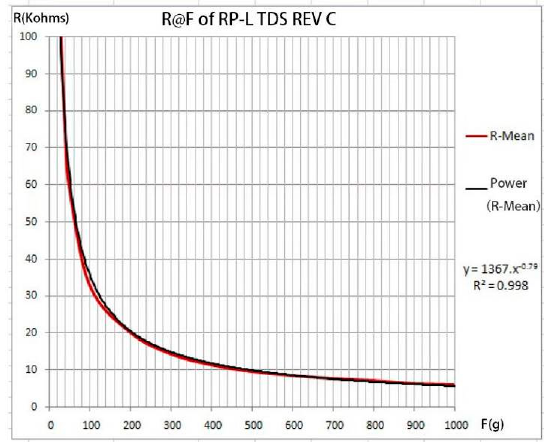
Figure 5. Pressure sensor calibration.